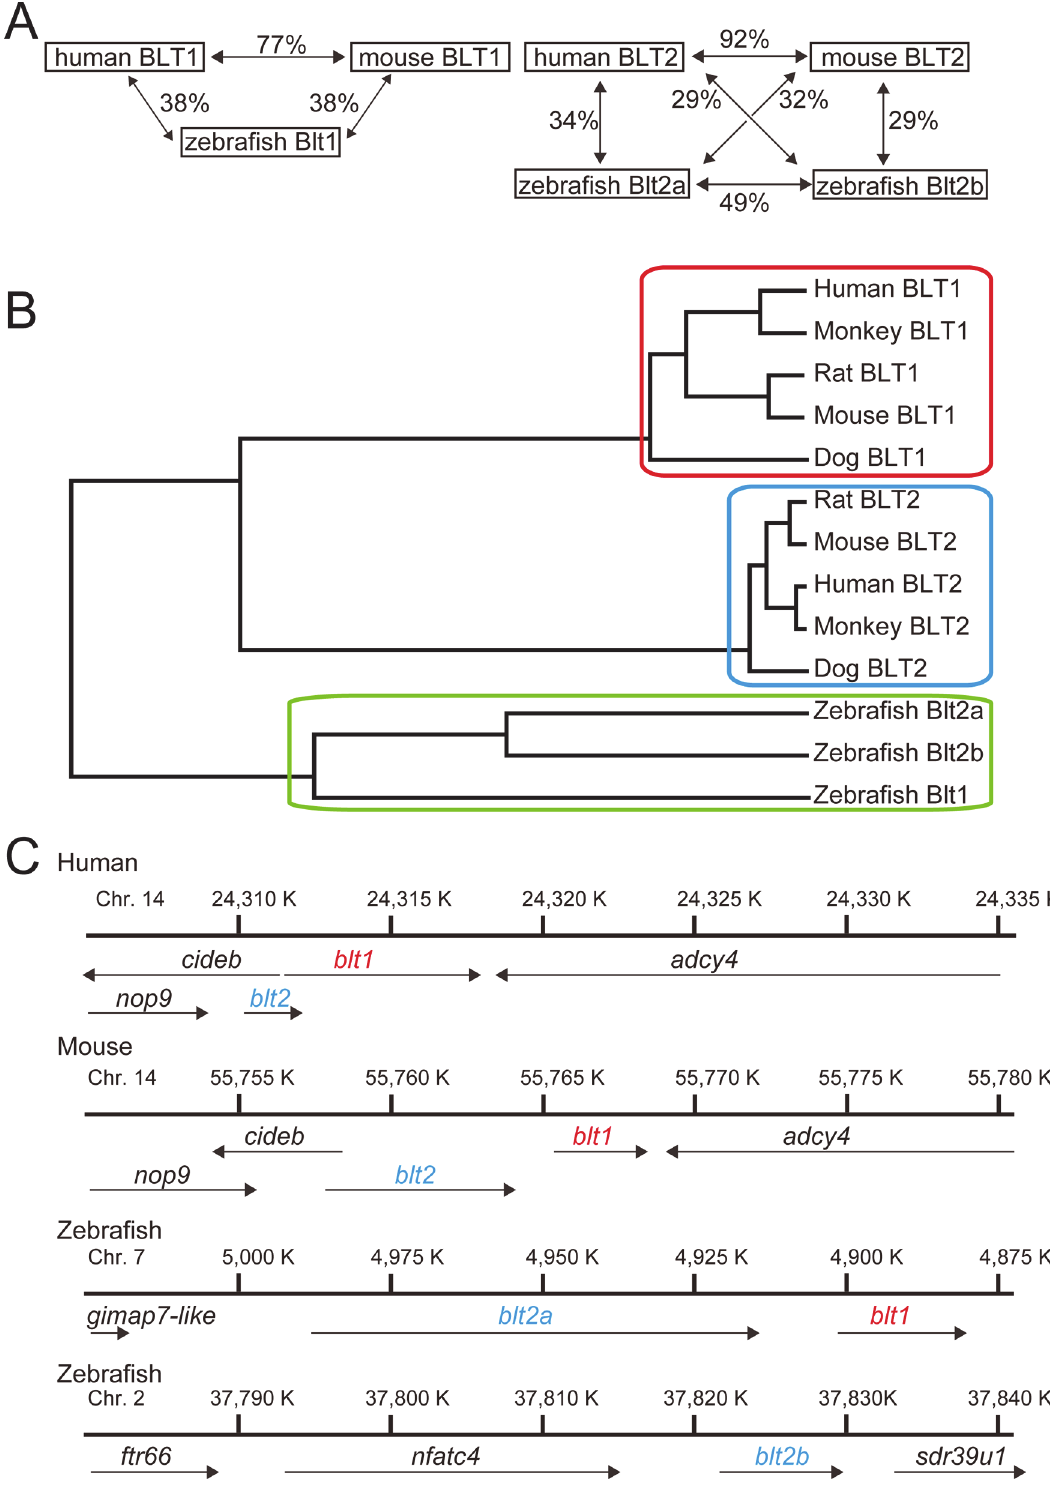
Fig 3. Sequence analysis of the zebrafish Blt receptors. (A) The amino acid identities among BLT1s (left) and BLT2s (right) are illustrated. (B) A phylogenic tree of BLT homologs in chordates was generated by GENETEX-MAC using the Unweighted Pair Group Method using the arithmetic Average (UPGMA). (C) Chromosomal locations of the human, mouse, and zebrafish blt1 and blt2 genes are shown. Chr., chromosome; cideb , cell death-inducing dffa-like effector b; nop9 , nucleolar protein; adcy4 , adenylate cyclase 4; gimap7 -like, GTPase IMAP family member 7-like; ftr66 , fin TRIM family, member 66; nfatc4 , nuclear factor of activated T-cells, cytoplasmic, calcineurin-dependent 4; sdr39u1 , short chain dehydrogenase/reductase family 39U.